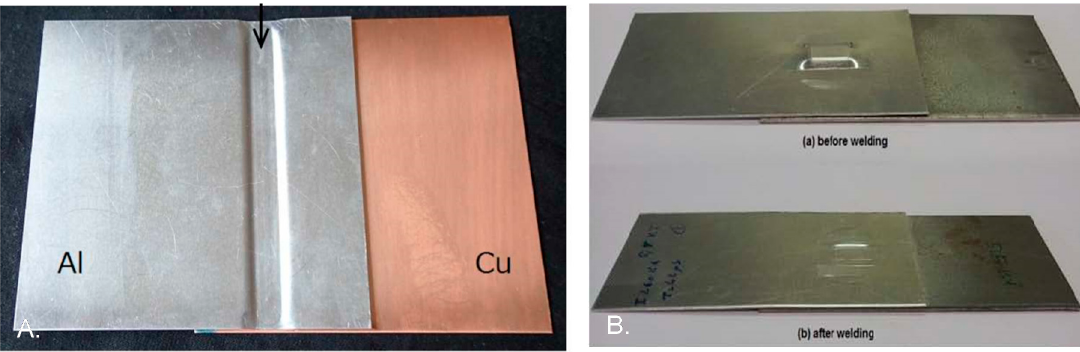
Figure 2. ( A ) Al / Cu MPW [21]; ( B ) MPSW